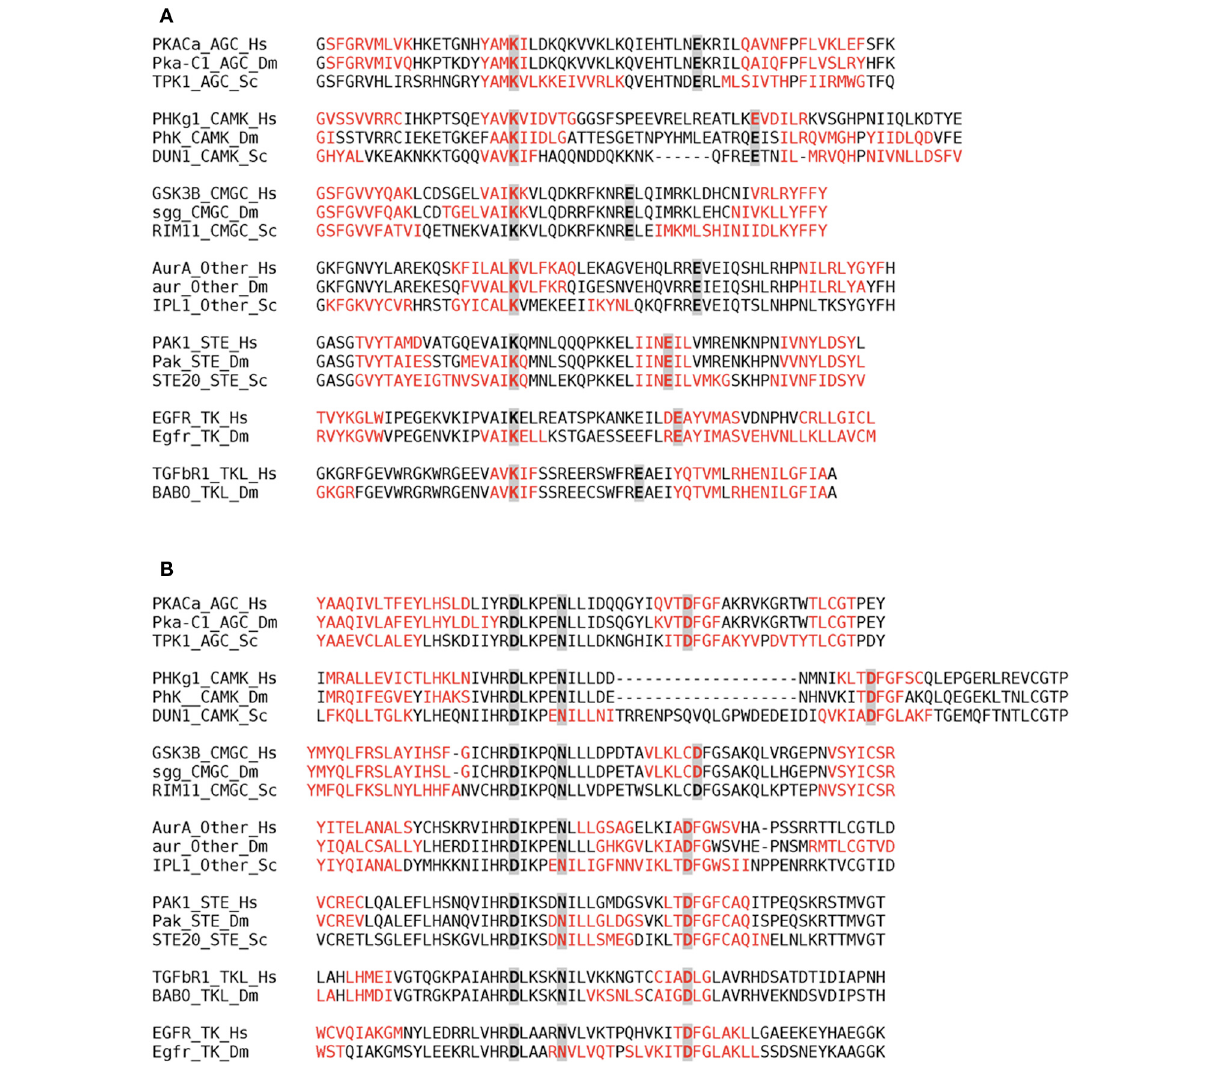
red in the alignment of representative proteins corresponding to different classes (AGC, CAMK, CMGC, Other, STE, TK, and TKL) in human (Hs), fruit fly (Dm), and yeast (Sc). The conserved catalytic residues are highlighted in